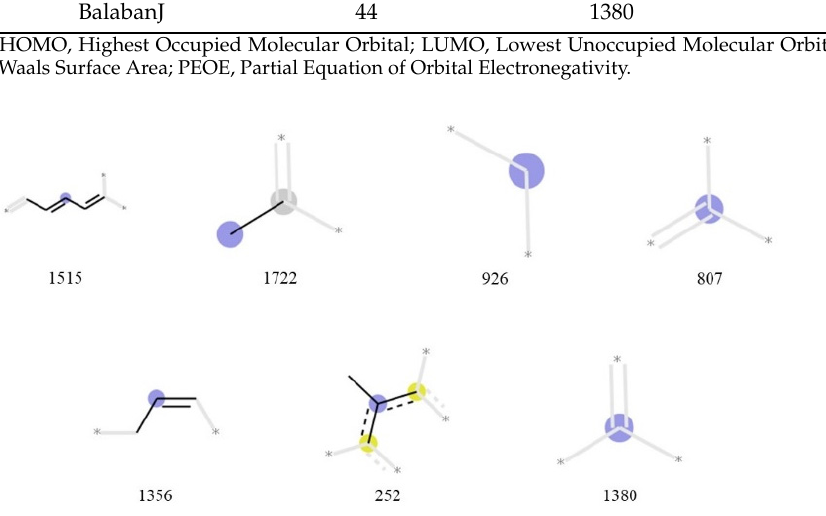
Figure 3. Important Morgan fingerprint bits. Bit 1515 suggests conjugate systems in a molecule. Bit 1722 represents a methyl group. Bits 926, 807, and 1380 represent carbon atoms. Bit 1356 suggests an allyl group or an unsaturated aliphatic carbon ring. Bit 252 represents an aromatic ring that has a methyl group.